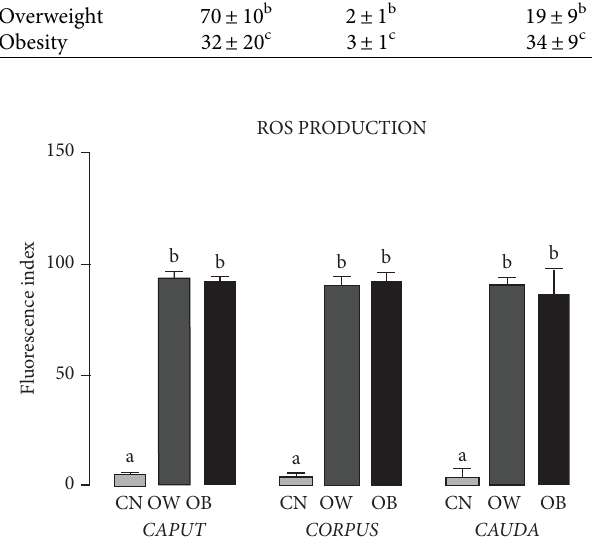
Figure 4: ROS production in the plasmatic membrane of the spermatozoa in the caput , corpus, and cauda regions of the epi- didymides of the rats fed for four weeks with regular chow (control group (CN)) or hyperlipidemic diets (overweight (OW) and obese (OB) groups). Bars represent mean ± SD. Letters show significant differences between the groups, P < 0 . 05 (CN vs. OW vs. OB). Fluorescence index � (average) (number of events).